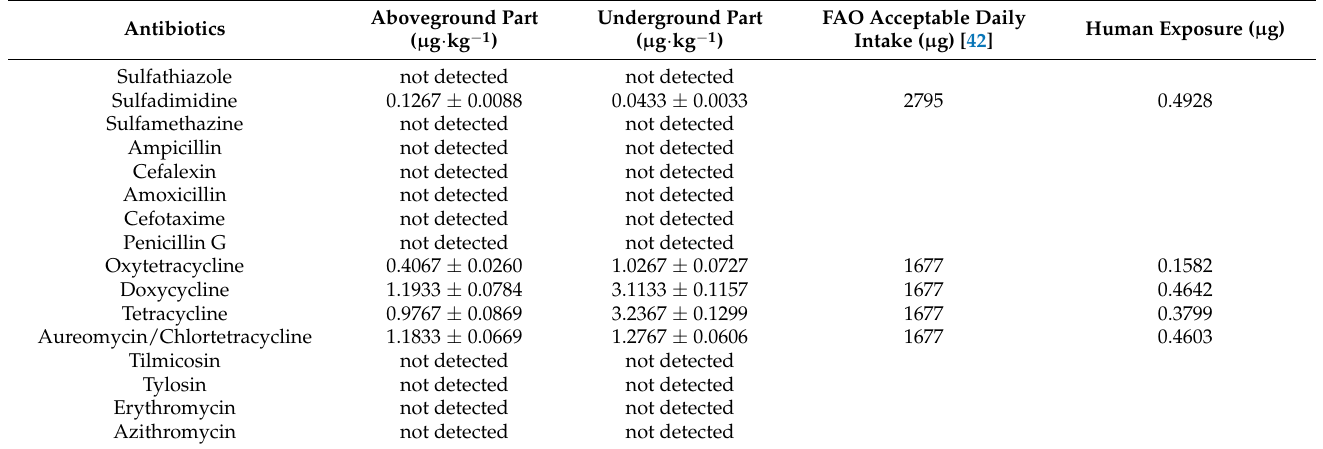
Table 4. Content of antibiotics and human exposure to antibiotics in water dropwort.